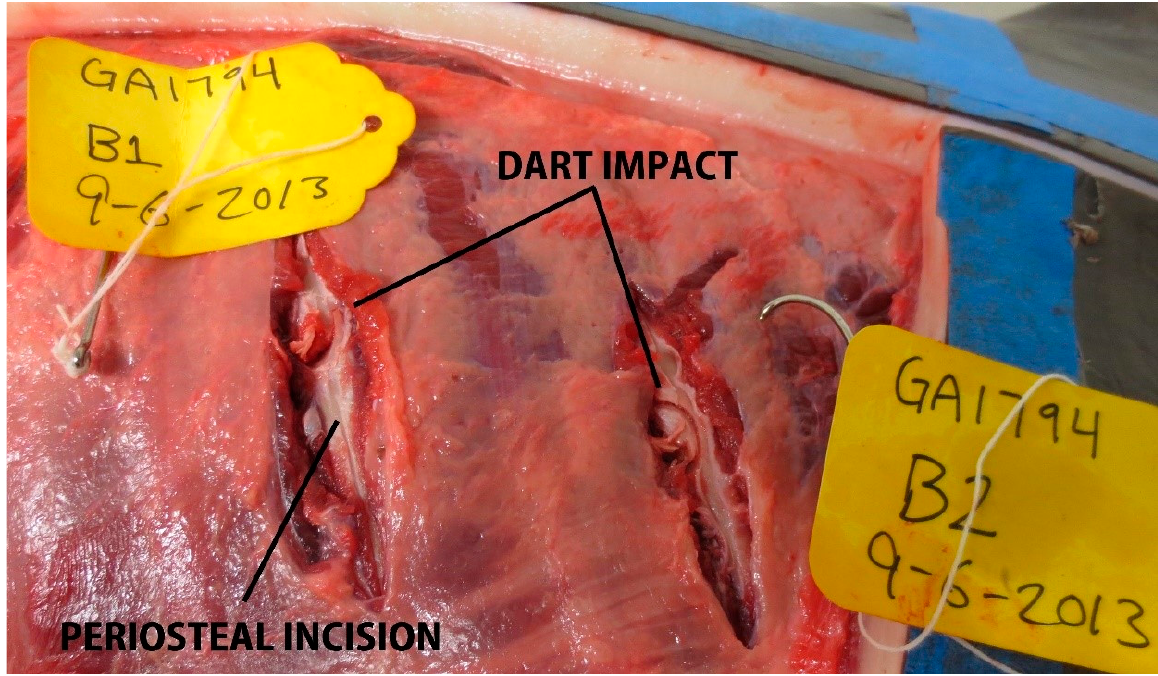
Figure 5. Rib impacts to GA1794 (subadult), with a complete rib fracture for impact GA1794-B1.